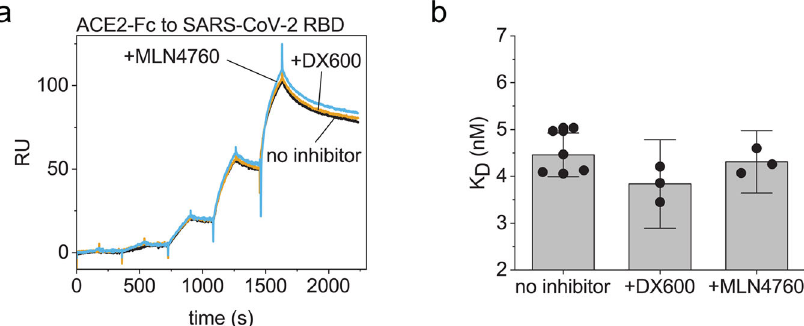
Fig. 4 Binding of ACE2-IgG4-Fc to immobilized SARS-CoV-2 RBD. a Overlay of sensorgrams. b Calculated binding constants from the measurements. The bar shows the mean value with 95% con fi dence intervals as error bars. The circles are the